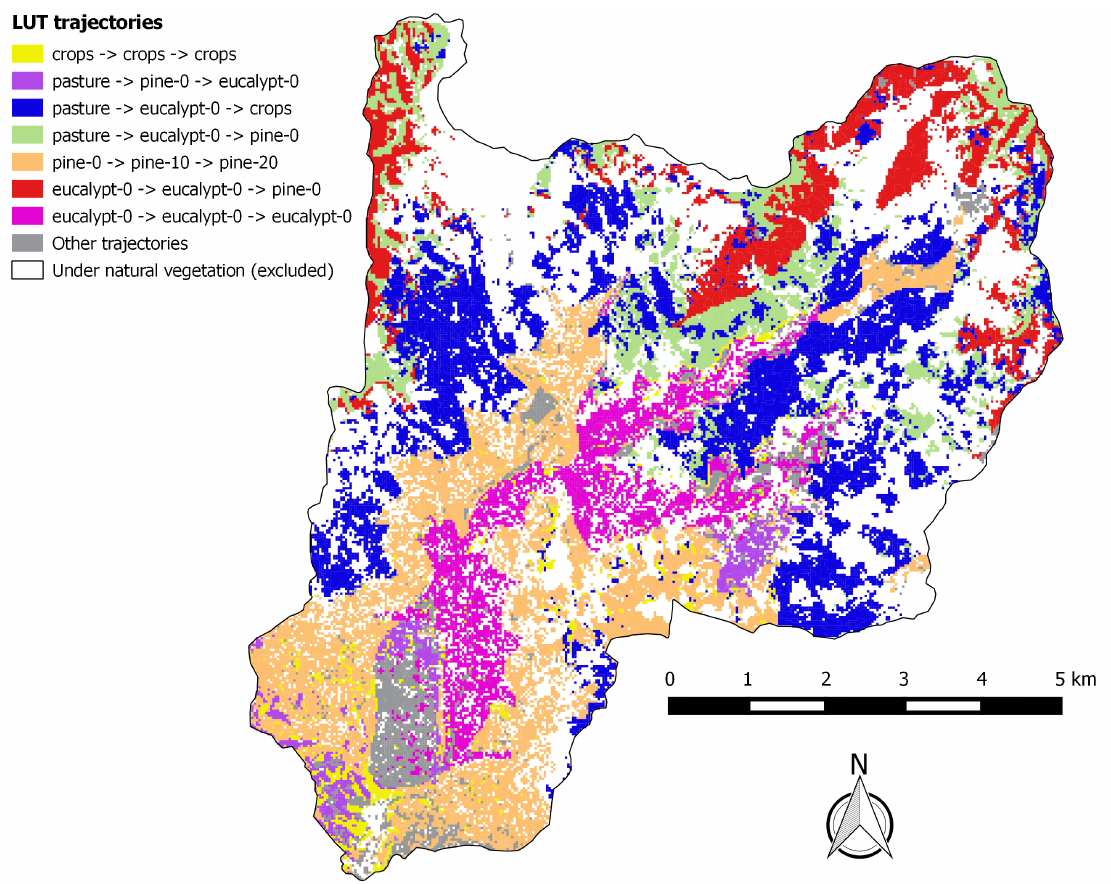
Figure 3. Distribution of land use trajectories over the Tabacay catchment that optimizes land performance, obtained by applying BIOLP for the reference scenario. The category “Other trajectories” in the legend comprises 20 different trajectories that were assigned by BIOLP to relatively small areas.